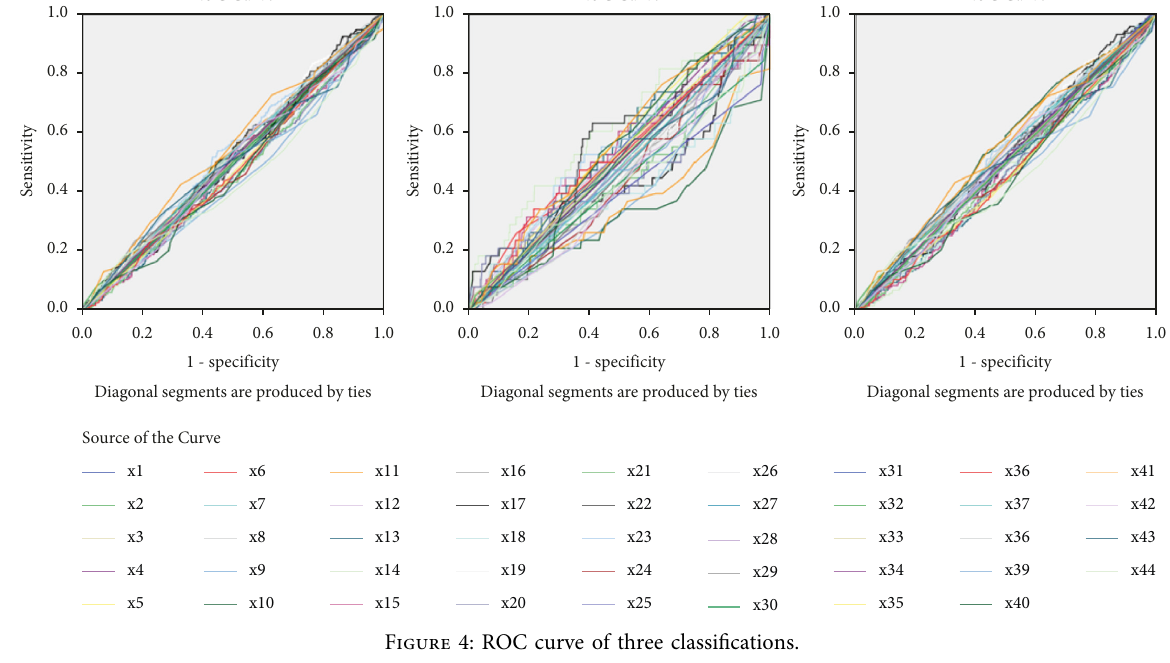
Table 4: Screening results of depth-weighted fuzzy Bayesian